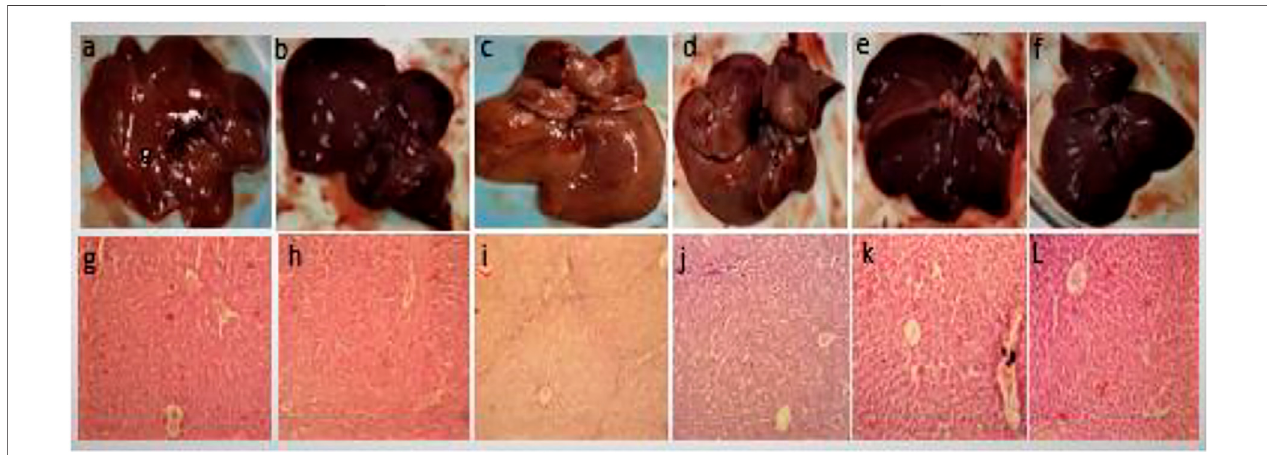
FIGURE 5 | Gross anatomical features of livers. Control group (A,G) , GREE-treated group (B,H) , CCl 4 -treated group (C,I) , CCl 4 +GREE (100 mg/kgbw)-treated group (D,J) , CCl 4 +GREE (300 mg/kgbw)-treated group (E,K), and CCl 4 + GREE (500 mg/kgbw)-treated group (F,L) . Livers were removed, washed with normal saline, and